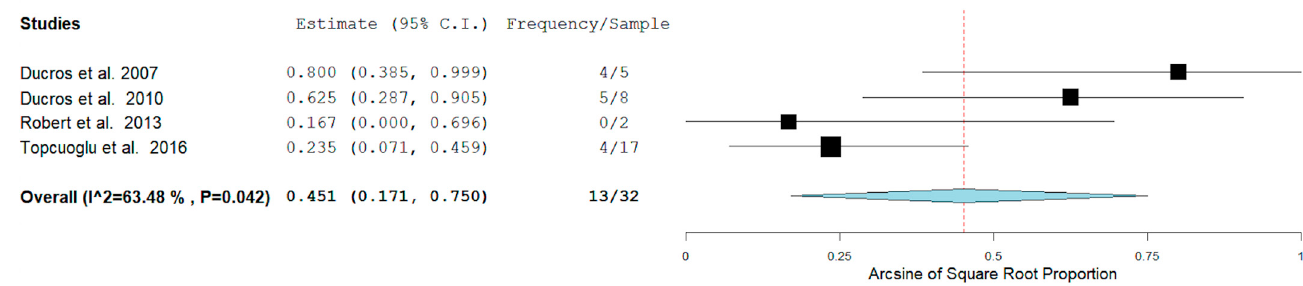
Figure 4. Rate of ICH among females with RCVS in the Postpartum Period.